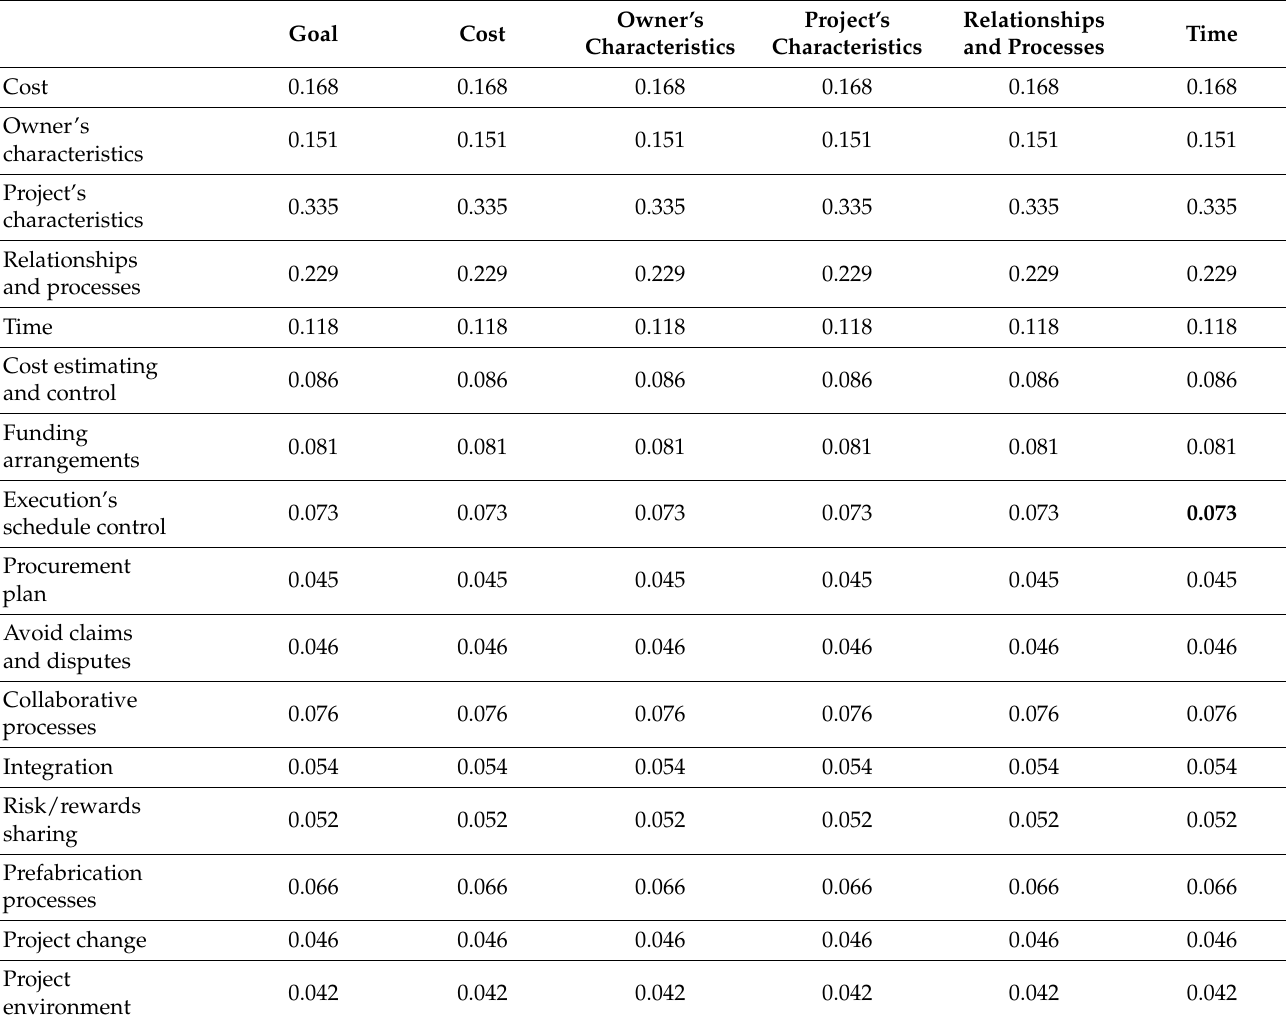
Table 4. The derived limit matrix of criteria and